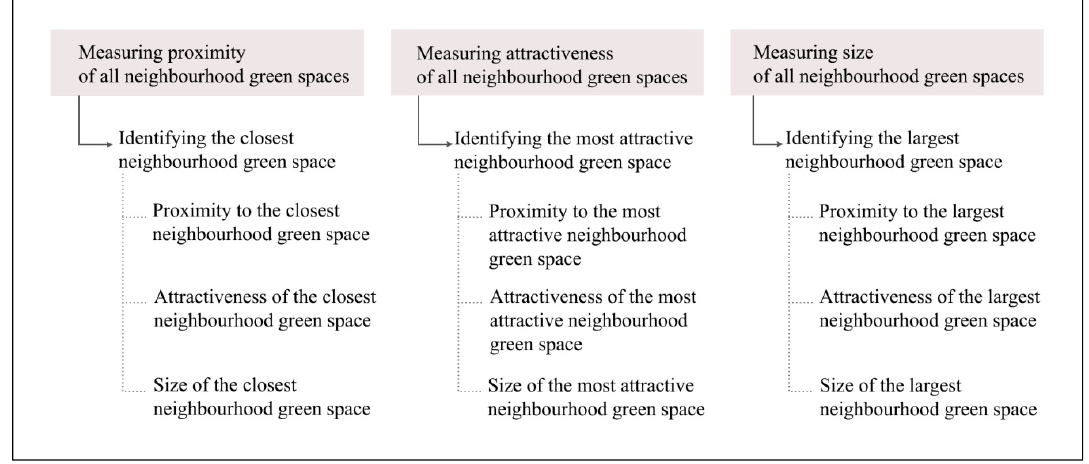
Figure 3. Identifying three types of neighbourhood green spaces and their characteristics.